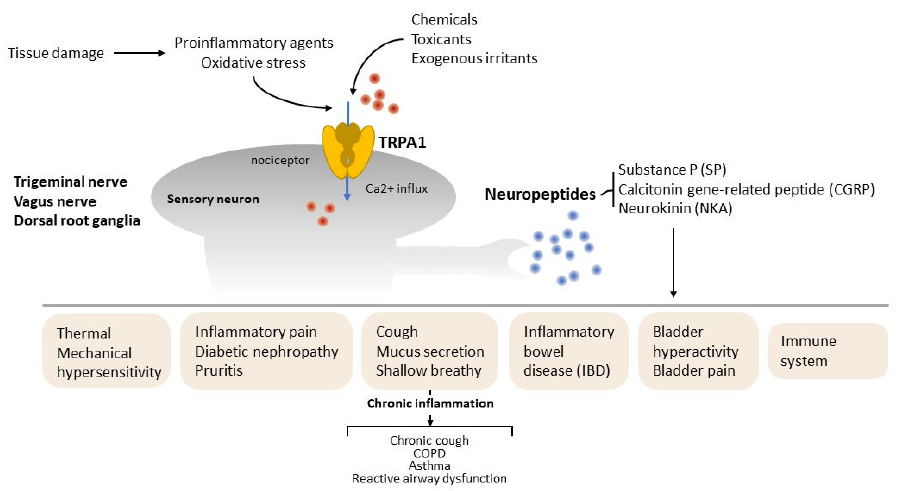
Figure 2. The role of TRPA1 on neurogenic inflammation. TRPA1 is expressed by sensory afferents with cell bodies in the vagal nerve, trigeminal ganglia and dorsal root ganglia that innervate peripheral targets. TRPA1 channel was activated by endogenous oxidative stress or proinflammatory agents after tissue damage. Chemicals, toxicants and exogenous irritants released neuropeptides, such as substance P (SP), calcitonin gene-related peptide (CGRP) and neurokinin A (NKA), to regulate tissue injury and inflammation. Red dots indicate Ca 2+ and blue dots indicate